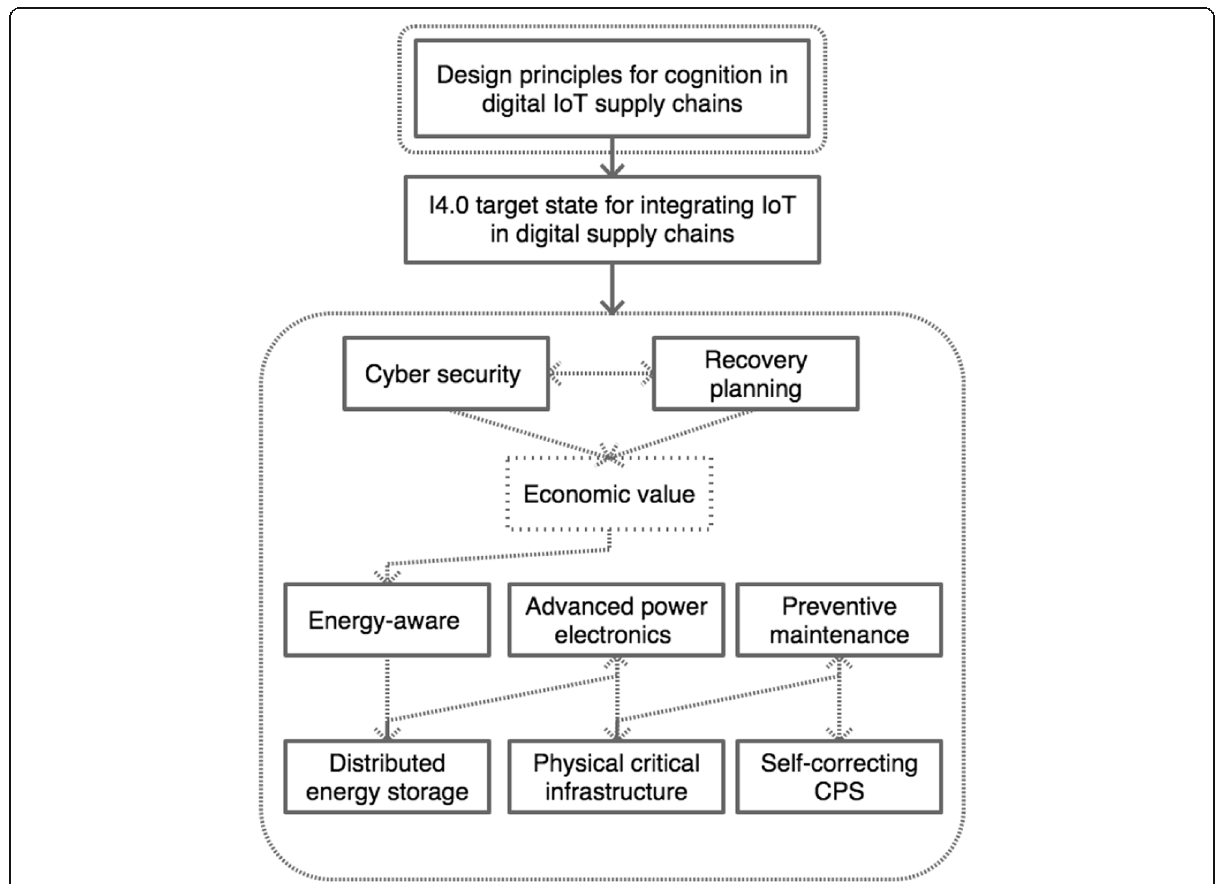
Fig. 2 I4.0 target state for integrating IIoT in digital supply